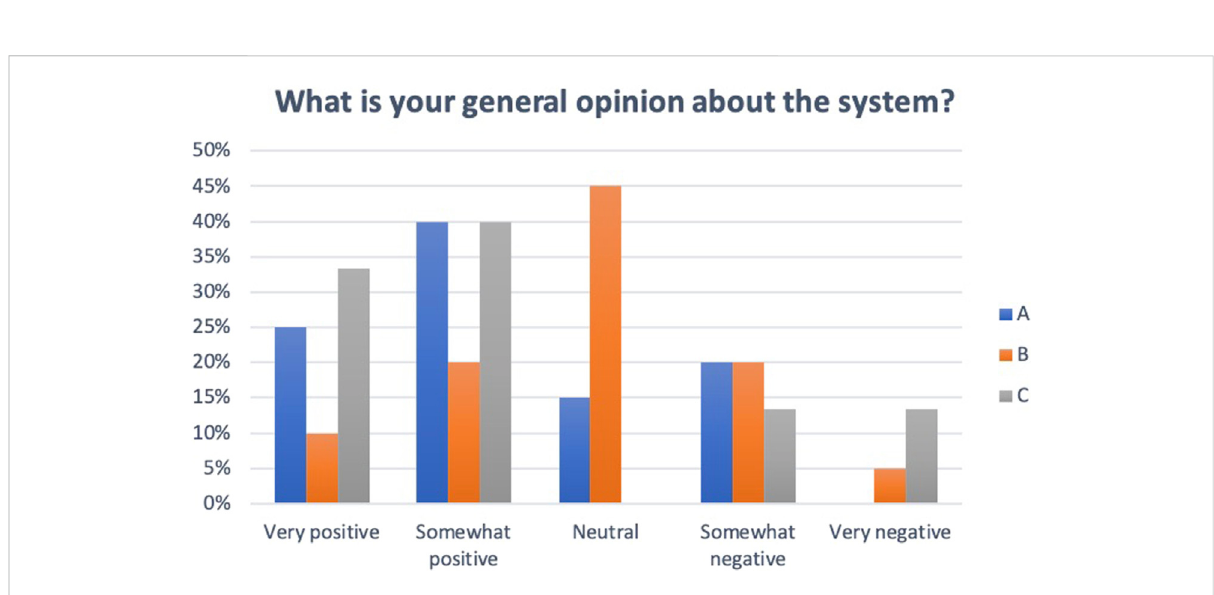
FIGURE 19 Participants ’ general opinion about the eHMI